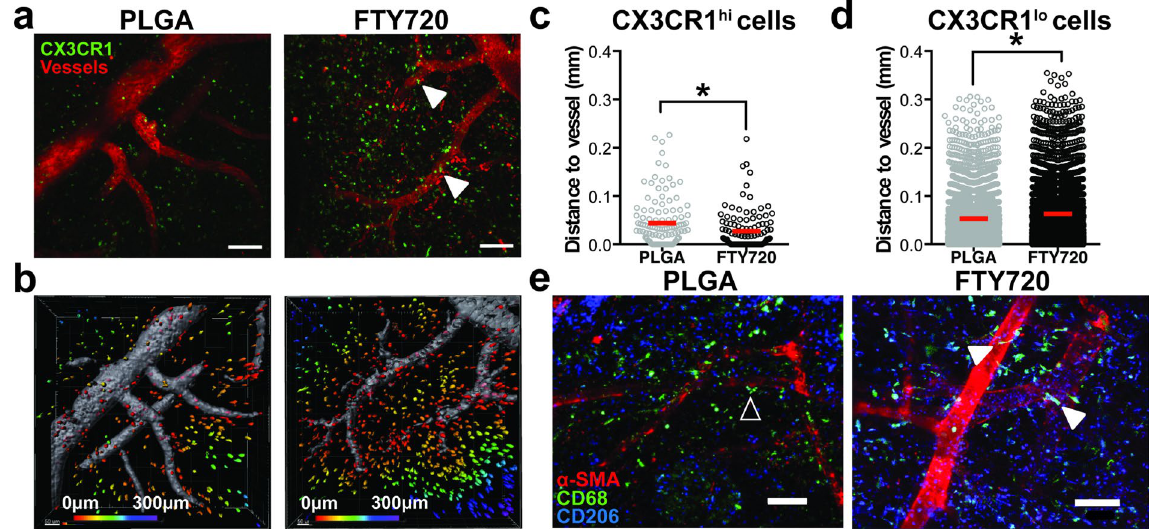
Figure 6. FTY720 recruits non-classical monocytes and CD206 + macrophages to perivascular niches in inflamed tissue. ( a ) Intravital imaging of DWCs in CX3CR1 GFP/ + transgenic mice 1 day post-injury. CX3CR1 hi cells preferentially accumulated around peri-implant arterioles (white arrows) ( b ) Representative surface renderings of CX3CR1 + cells, color-coded according to distance from the closest blood vessel with red cells being closest to blood vessels and purple cells being the farthest away. Vessels were labeled with i.v. injection of rhodamine-dextran. ( c ) Distance to the nearest blood vessels of CX3CR1 hi cells in animals treated with FTY720 compared to unloaded PLGA controls. ( d ) Distance to the nearest blood vessels of CX3CR1 lo cells. Statistical